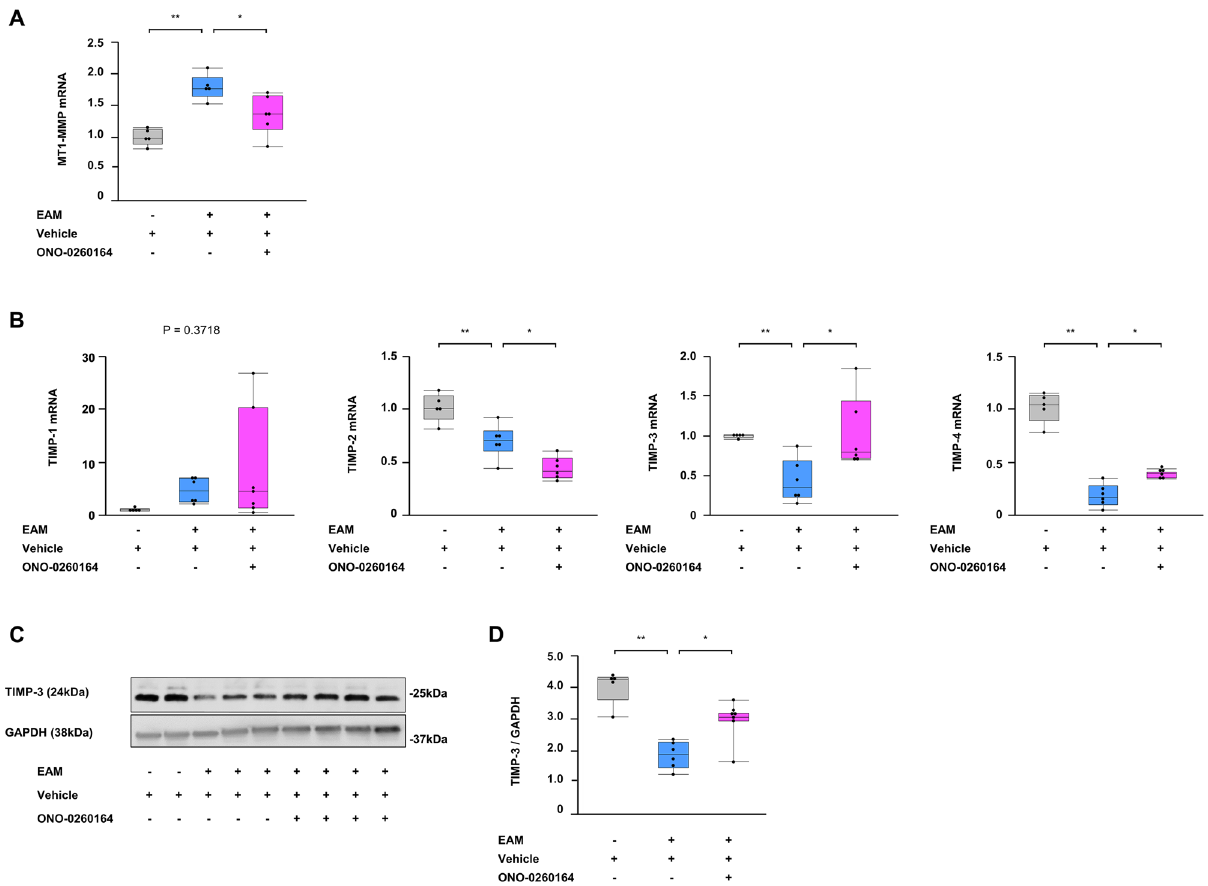
Figure 4. Endogenous regulators of matrix metalloproteinase (MMP) in the heart of experimental autoimmune myocarditis (EAM) mice. ( A , B ) Reverse transcription-quantitative PCR for membrane type (MT)-1 MMP and tissue inhibitors of metalloproteinases (TIMPs) and ( C ) representative western blot (cropped blot) and ( D ) densitometric analysis of the TIMP-3 in bulk heart tissues on day 56 obtained from non-EAM mice treated daily with vehicle (n = 5) or from EAM mice treated daily with vehicle (n = 6) or selective prostaglandin E2 receptor 4 (EP4) agonist (ONO-0260164) (n = 7) starting on day 14. Full-length blots of TIMP-3 and GAPDH are presented in Supplementary Fig. 4C. * P < 0.05 (vs. vehicle alone-treated EAM) or ** P < 0.05 (vs. non-EAM) calculated with 2-way ANOVA followed by the Bonferroni-Dunn post hoc testing